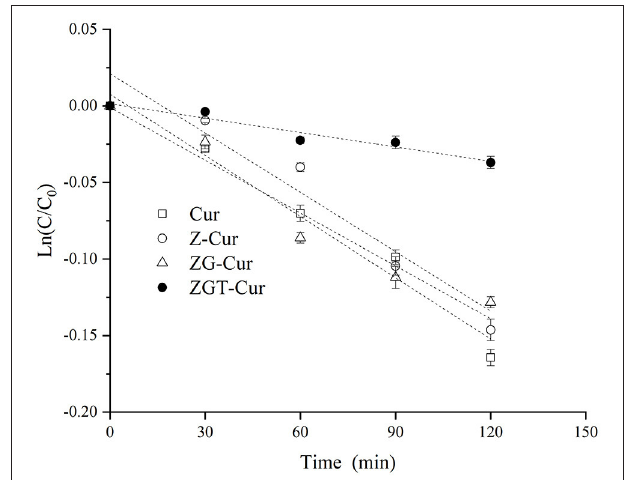
curve was less steep. This indicated that the degradation rate of Cur in the ZGT-Cur composite particles containing TA was slower.